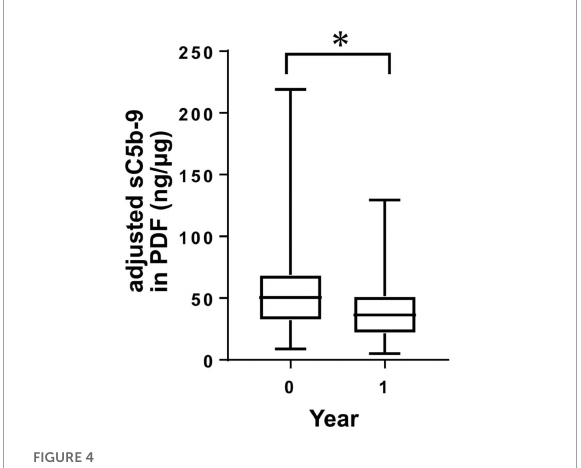
FIGURE4 Levels of sC5b-9 in peritoneal dialysis (PD) fluid (PDF) from PD patients during 1 year. Levels of sC5b-9 in PDF significantly decreased during 1 year. ∗ P < 0.05.